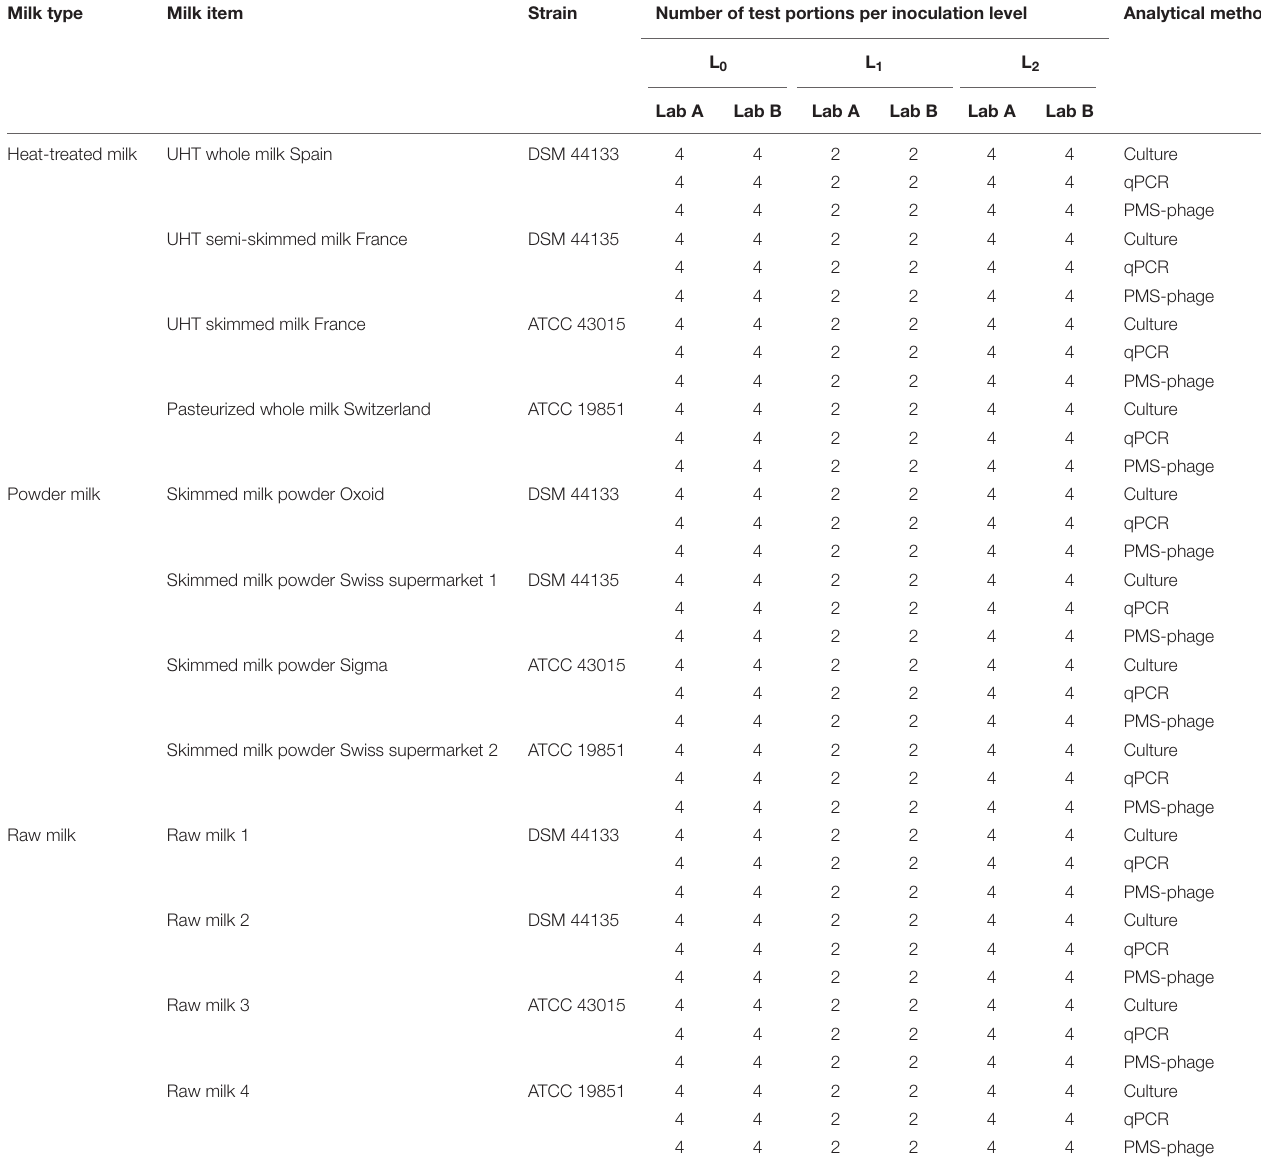
TABLE 1 | Sensitivity study experimental